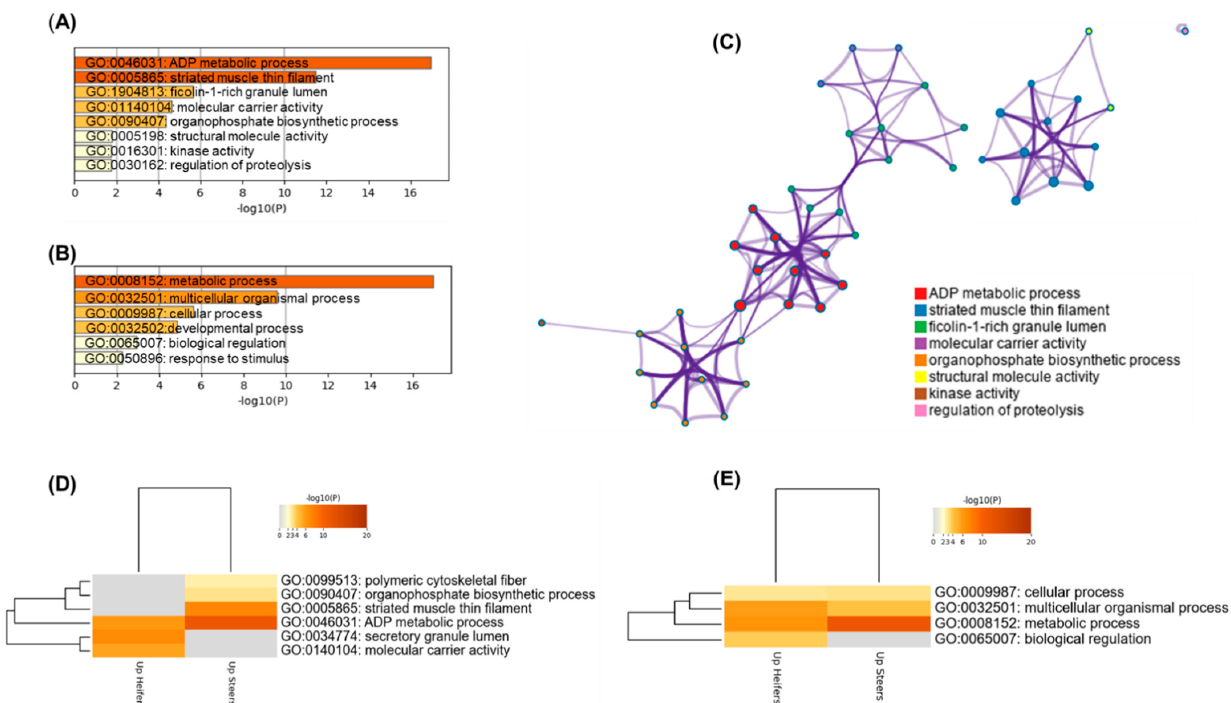
Figure 5. Bioinformatics analyses based on the differentially expressed proteins identified in this experiment. ( A ) Enriched ontology clusters based on the significantly enriched gene ontol- ogy (GO) terms obtained using the protein lists of steers ( n = 11) and heifers ( n = 12) identified in Longissimus thoracis muscle tissue of feedlot-finished immunocastrated F1 Montana-Nellore. ( B ) Enriched biological process. The graphs highlight all the enriched terms across the protein lists with the importance of energy metabolism (metabolic and ADP processes), metabolic, cellular and developmental processes according to − Log p -values. ( C ) Enriched network related to the previous terms of ( A ) highlighting the degree of interconnectedness. ( D , E ) Hierarchical heatmap clustering comparing the enriched GO terms within steers and heifers as well the main biological process in each condition. The heatmaps colored by the p -values are indicated by color, where grey cells indicate the lack of significant enrichment, palest brown indicates a low p -value and darkest brown indicates a high p